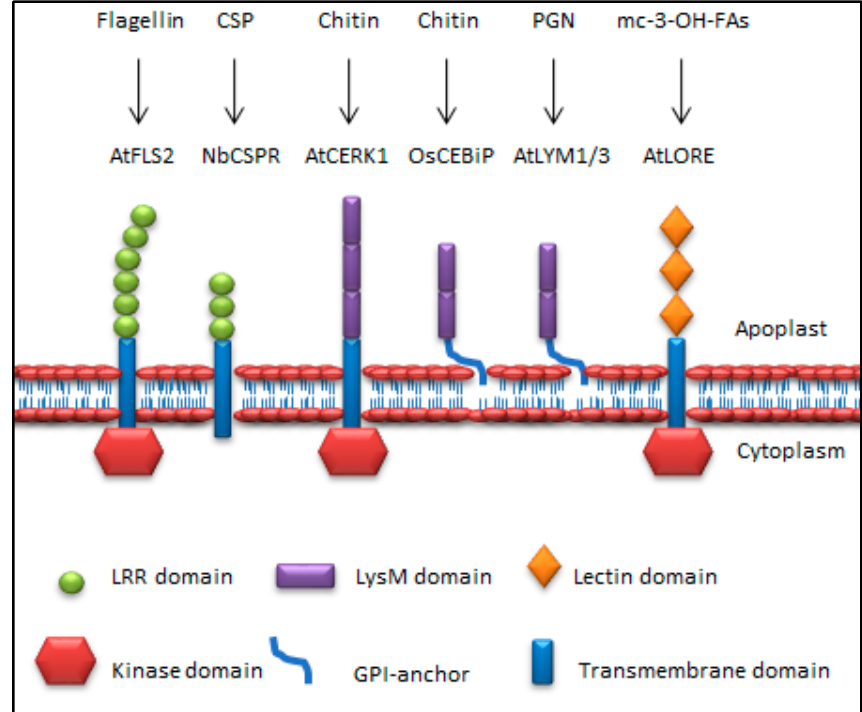
Figure 3. Structural configuration of plant PRRs. PRRs use different conserved external surfaces such as LRR-, LysM- or lectin domains to recognise MAMPs. Following, the transmembrane domain relays the perceived signal into the cell for the kinase domain to perform PRR activation, phosphorylation of downstream defence-related proteins and subsequent MTI induction. LRR = leucine-rich repeat, LysM = lysine motif, GPI = glycophosphatidyl